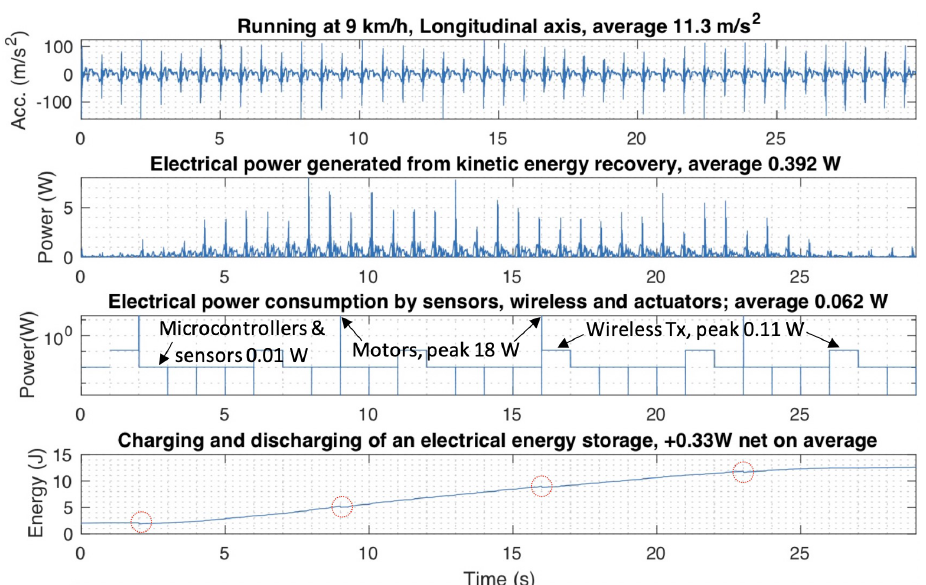
Figure 10. Simulated charging and discharging of an energy storage by energy recovery and electrical load, respectively, for a running scenario. A starting energy of 2 J is given within the